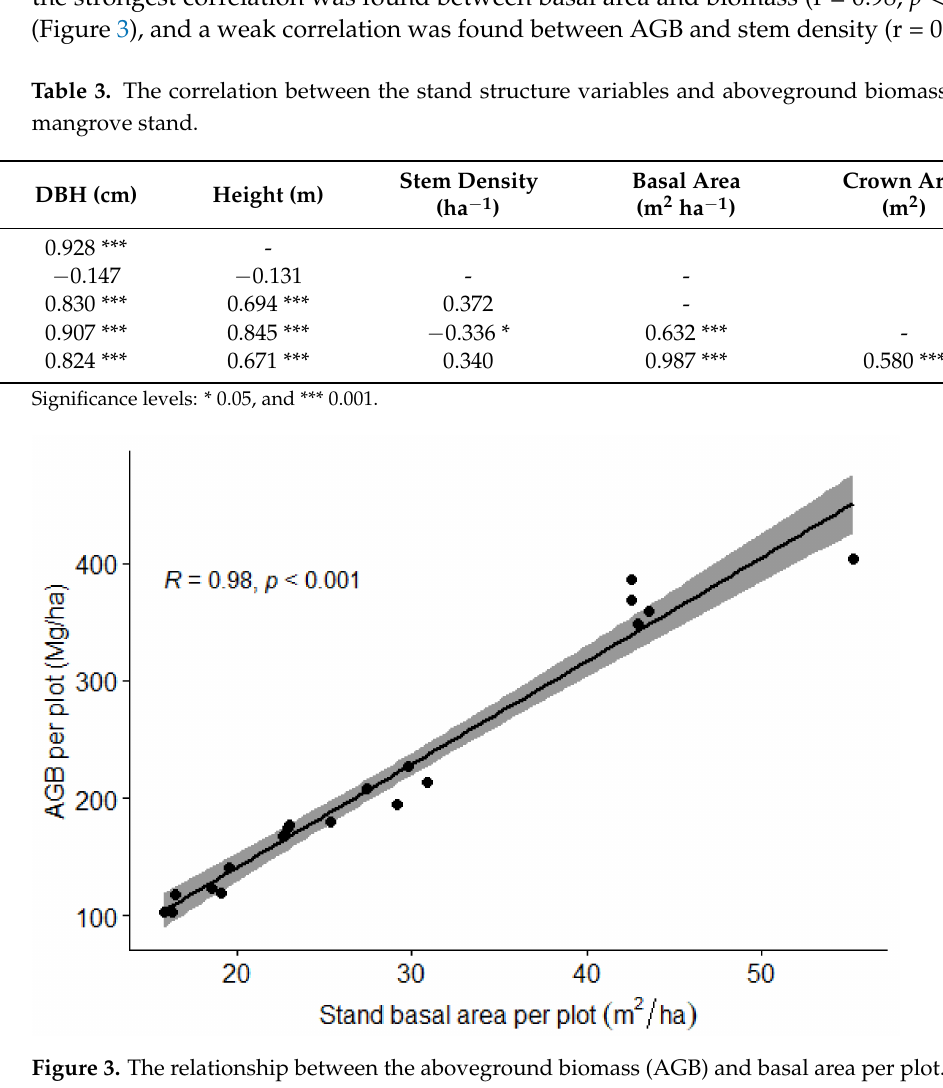
Figure 3. The relationship between the aboveground biomass (AGB) and basal area per plot. Above- and belowground carbon storage ranged between 10.87 and 191.21 Mg C ha − 1 and 4.67 and 65.69 Mg C ha − 1 for the present study, respectively (Table A1). The average AGC and BGC storage concentration at twenty-four plots was 100.34 ± 50.70 Mg C ha − 1 and 34.76 ± 16.59 Mg C ha − 1 . The vegetation carbon storage values for 3, 4, and